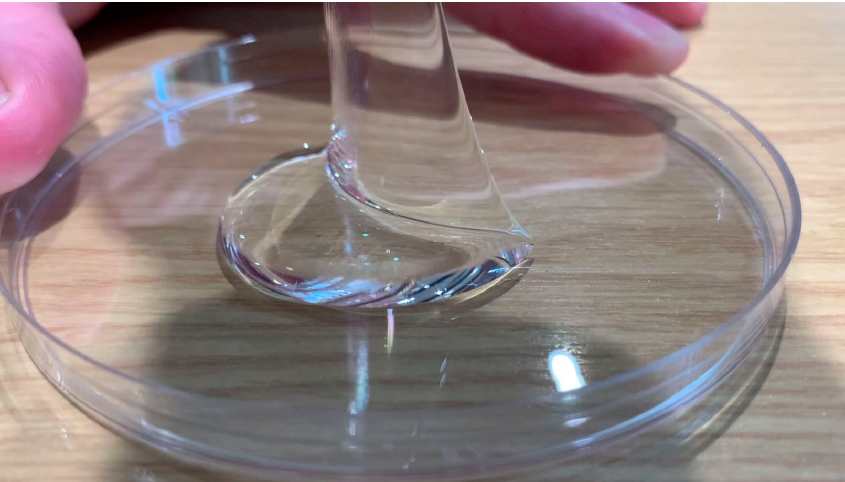
Figure 3. Smart hydrogel and its application in medical issues.